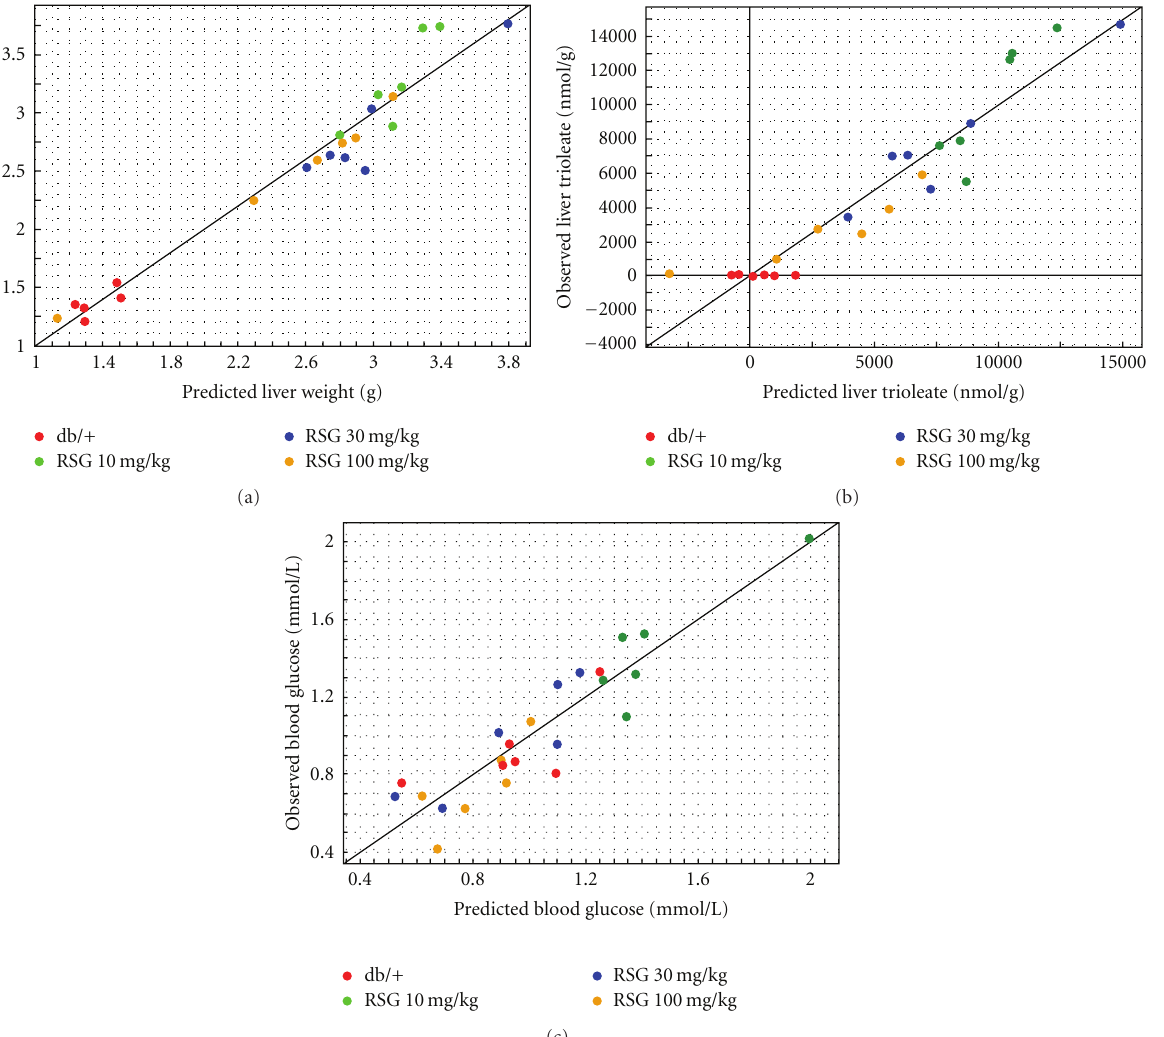
Figure 7: Generation of PLS models to predict physiological changes from multivariate gene expression data. Results show the correlations between the actual liver weight (a), the liver trioleate concentrations (b), the blood glucose level (c) and the predicted parameters from the PLS model. The normalised logs (ratio) of genes involved in glucose and lipid metabolism were used as predictor variables (X) and physiological parameters as response variables (Y). All variables were centred and scaled to unit variance, before the PLS analysis was